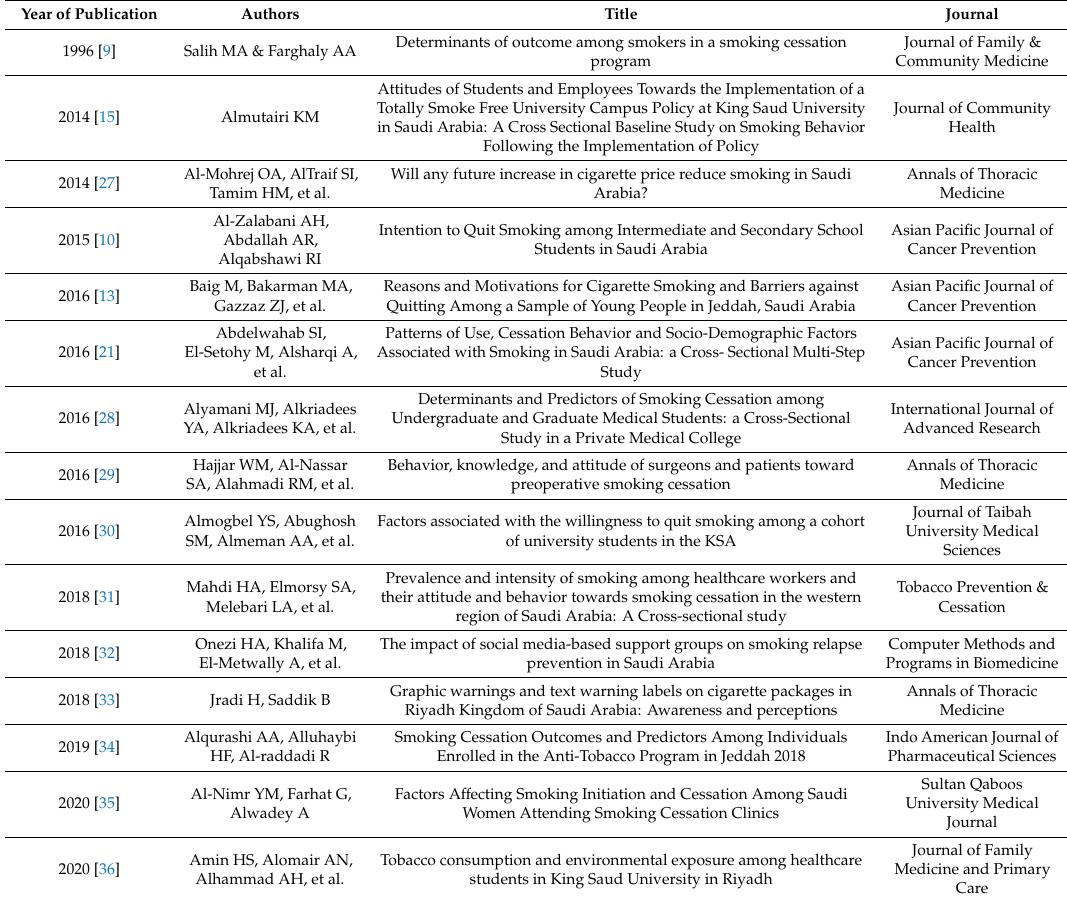
Table 1. Articles identified in the